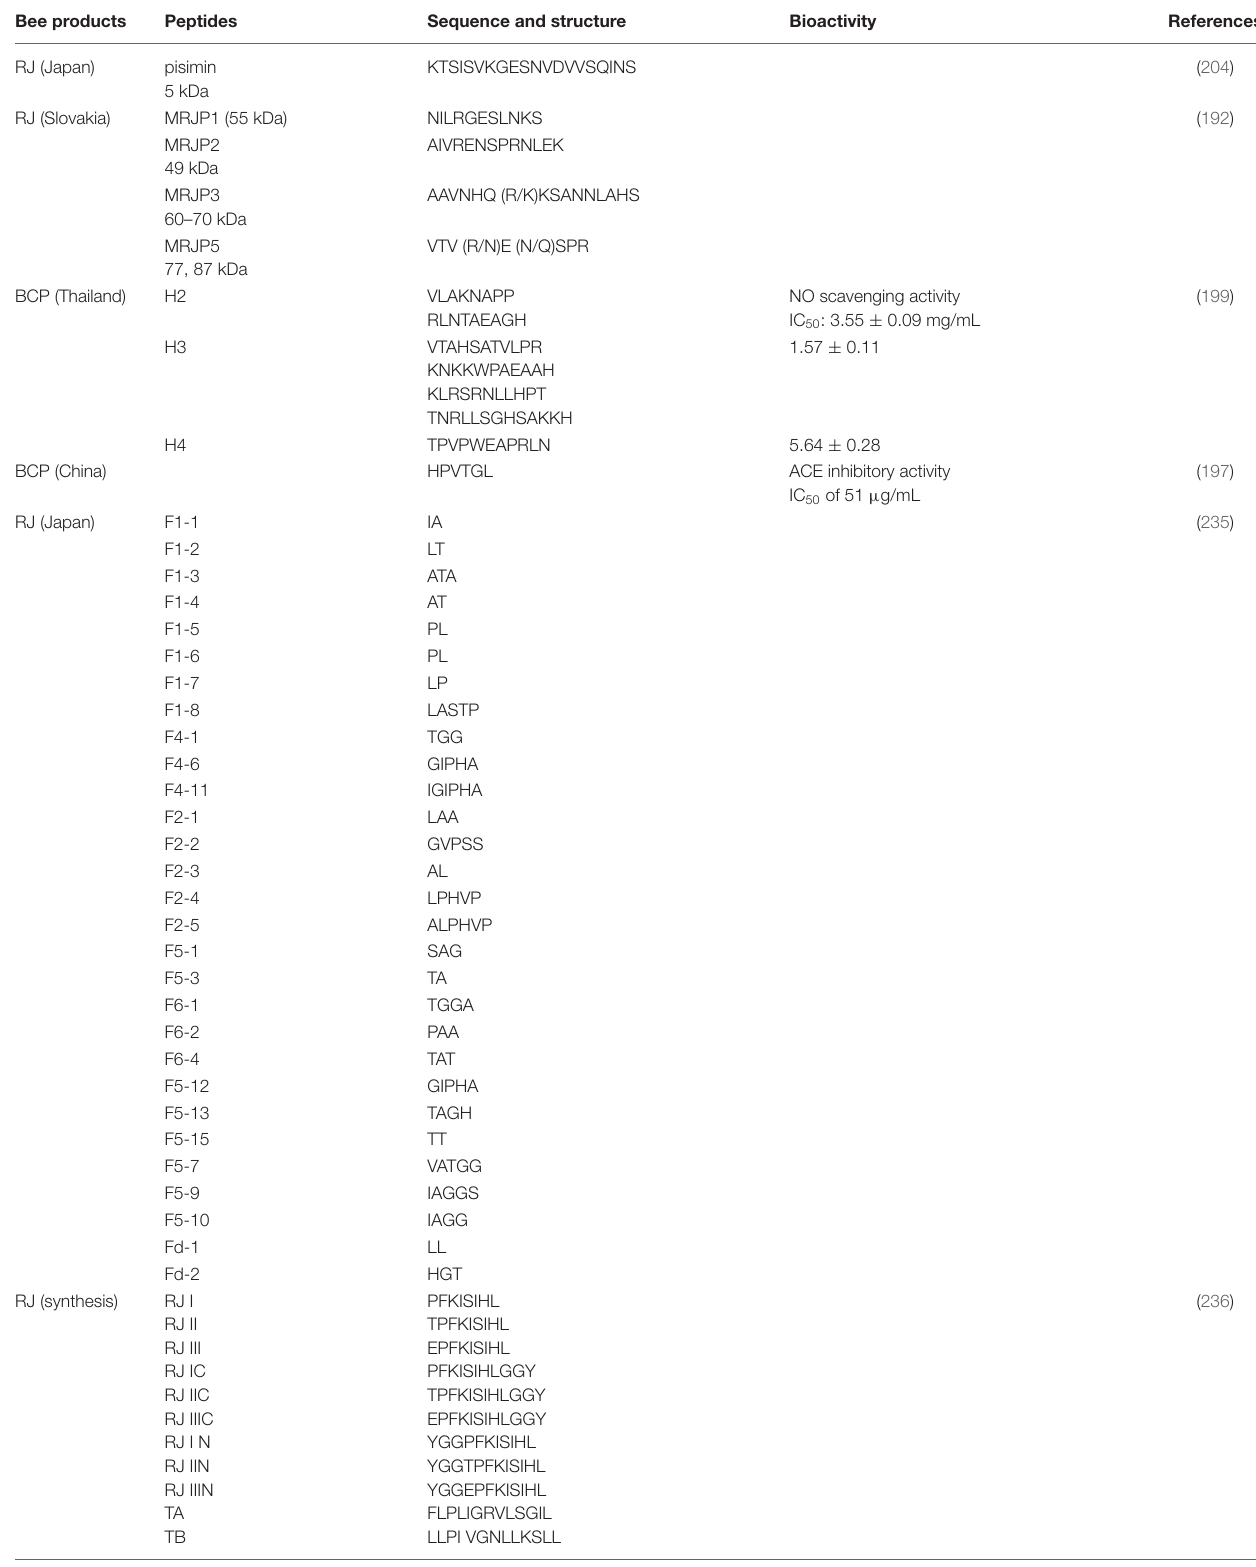
TABLE 6 | Peptides sequence and bioactivity from bee products. Bee products